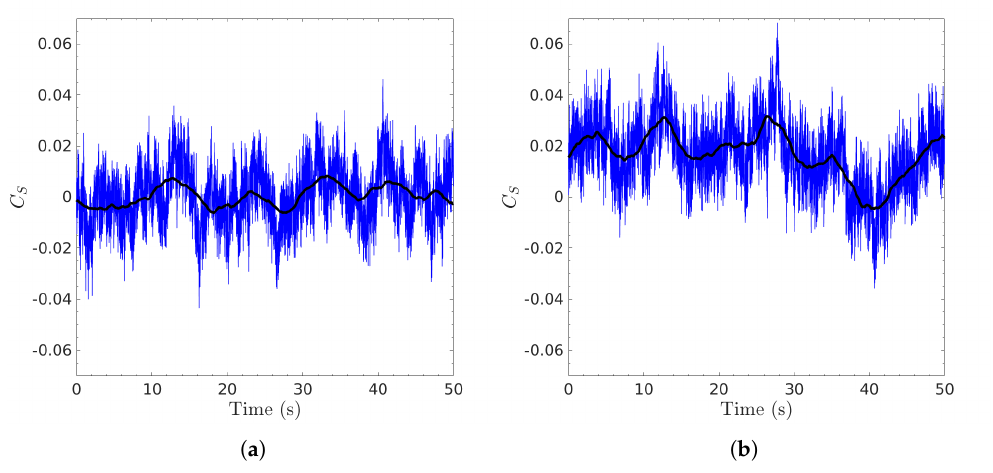
Figure A3. Time-trace of the side-force coefficient C S for the rotating wheels case on the ( a ) coarse mesh and ( b ) medium mesh overlayed with a sliding average using a window size associated with 0.2 Hz